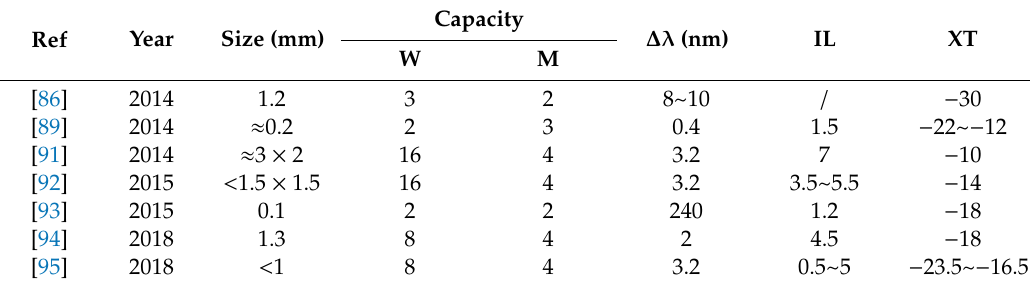
Table 2. Summary of the reported silicon wavelength / mode hybrid